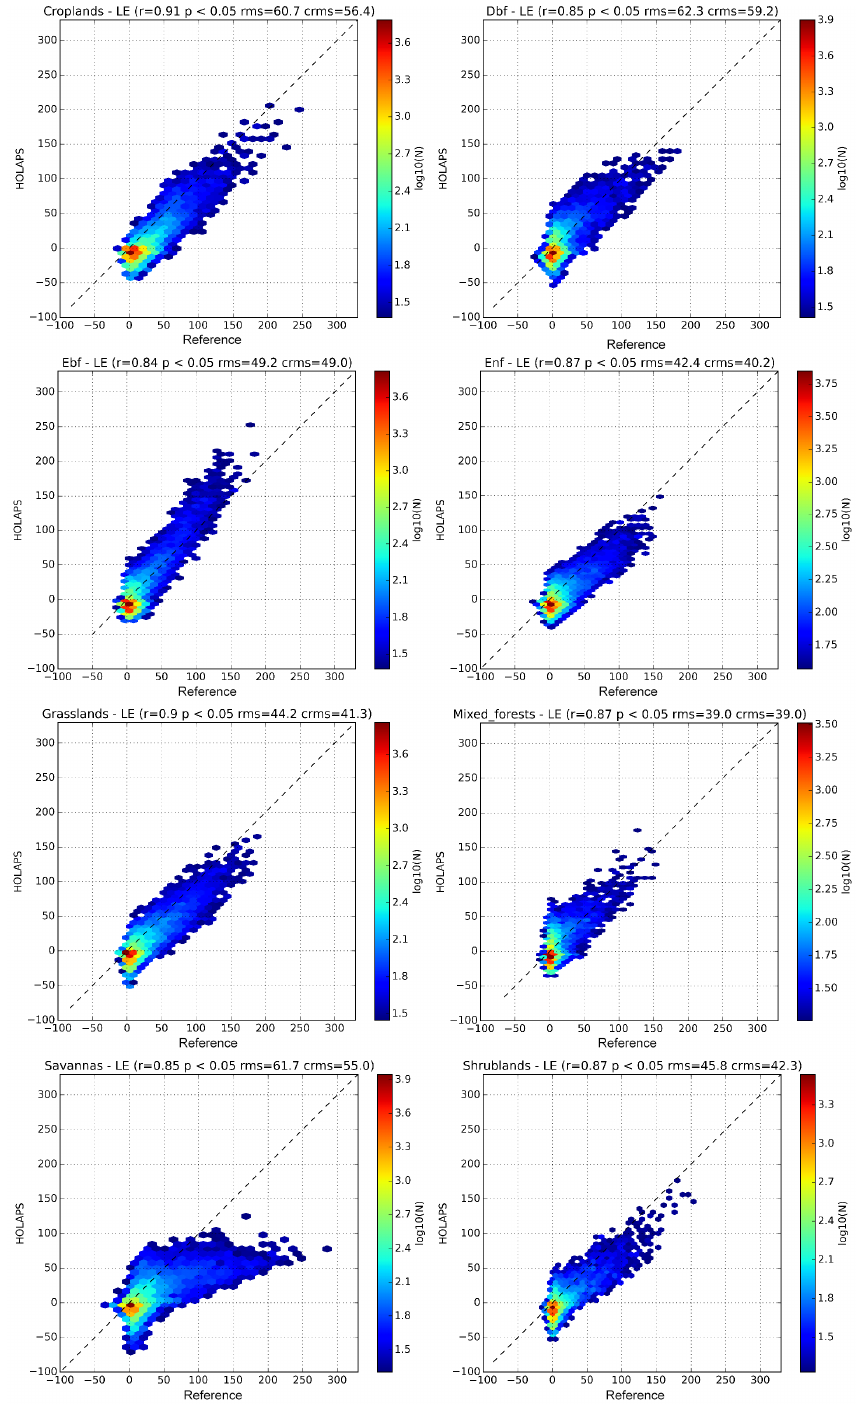
Figure E1. Comparison of HOLAPS latent heat flux for different biomes using results from all stations and years: Dbf is deciduous broadleaf forest, Ebf is evergreen broadleaf forest, Enf is evergreen needleleaf forest. Units in Wm − 2 .